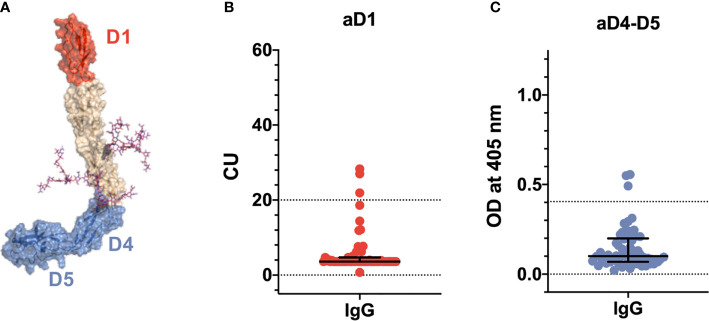
Epitope specificity of anti-β2GPI antibodies in COVID-19 patients. (A) Three-dimensional structure of β2GPI solved at 2.4 Å by X-ray crystallography [PDI ID: 6V06 (27)] displaying the positioning of the fragments used in this study. The N-terminal D1 is shown in red. The C-terminal D4-5 fragment is shown in blue. N-linked glycosylations are shown as magenta stick. Titers of anti-D1 (B) and anti-D4-5 antibodies (C) in 58 COVID-19 patients detected by chemiluminescence and ELISA, respectively. Values are expressed as median levels [first and third quartile]. Anti-D1(aD1): 3.6 [3.6–4.7]. Anti-D4-D5 (aD4-D5): 0.10 [0.068–0.199]. Cutoff values are >20 chemiluminescent units (CU) and >0.405 optical units (OD) for aD1 and aD4-D5, respectively.